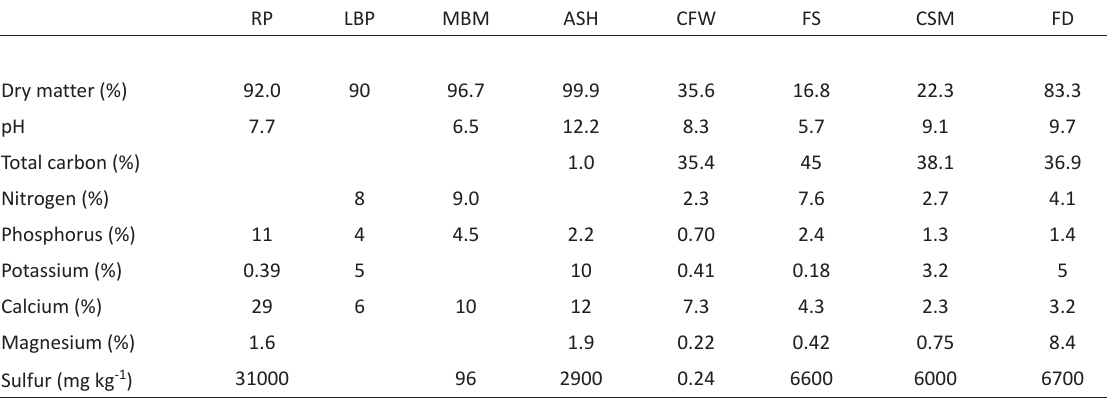
Table 1. Chemical composition of materials used in the experiment